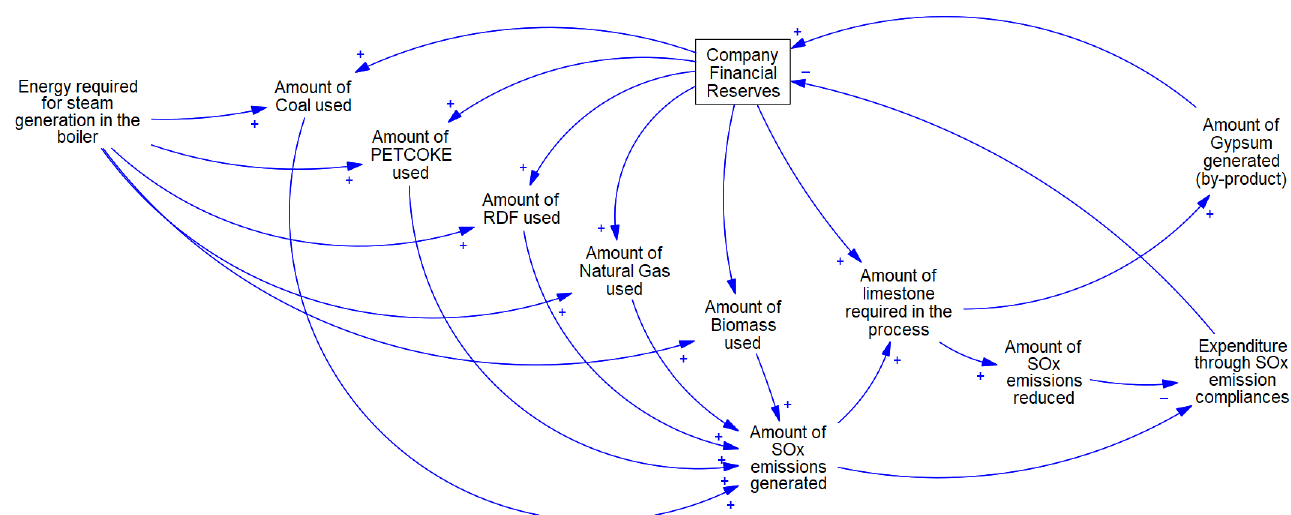
Figure 2. CLD of the Flue Gas Desulphurisation Module for SOx emission reduction.